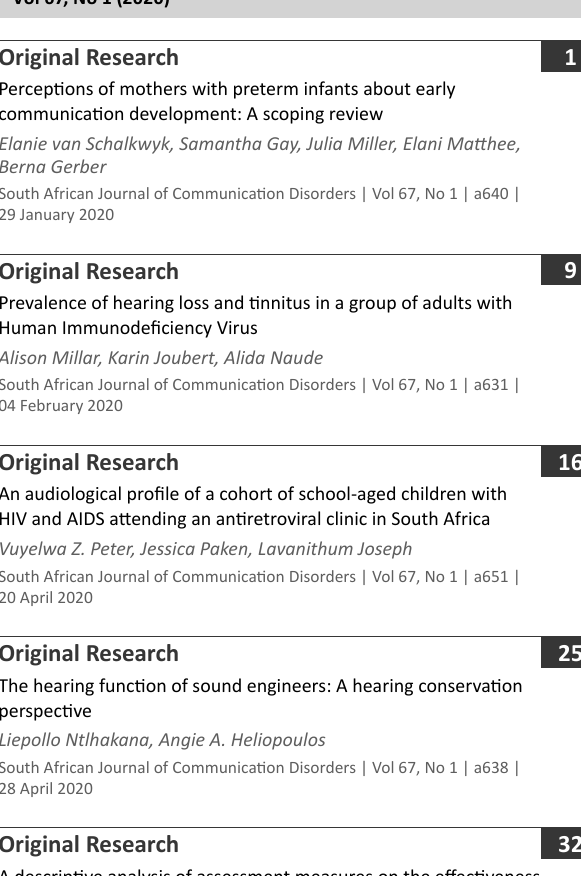
Contextual influences on sentence repetition as a tool for